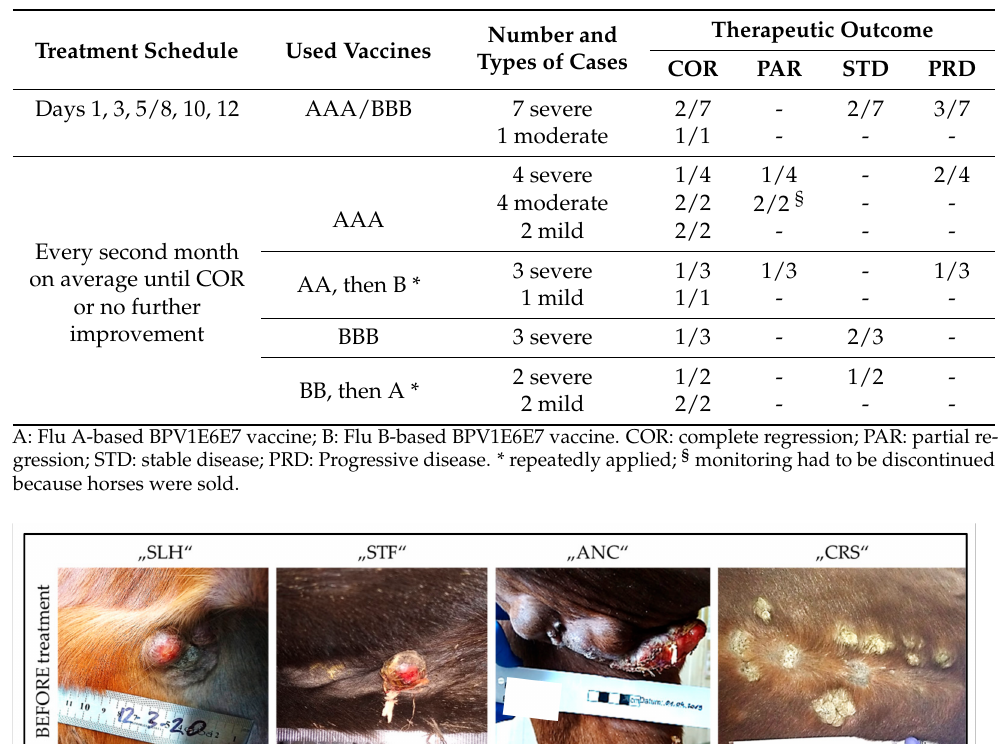
Table 1. Treatment modalities and outcome as of March 2023.